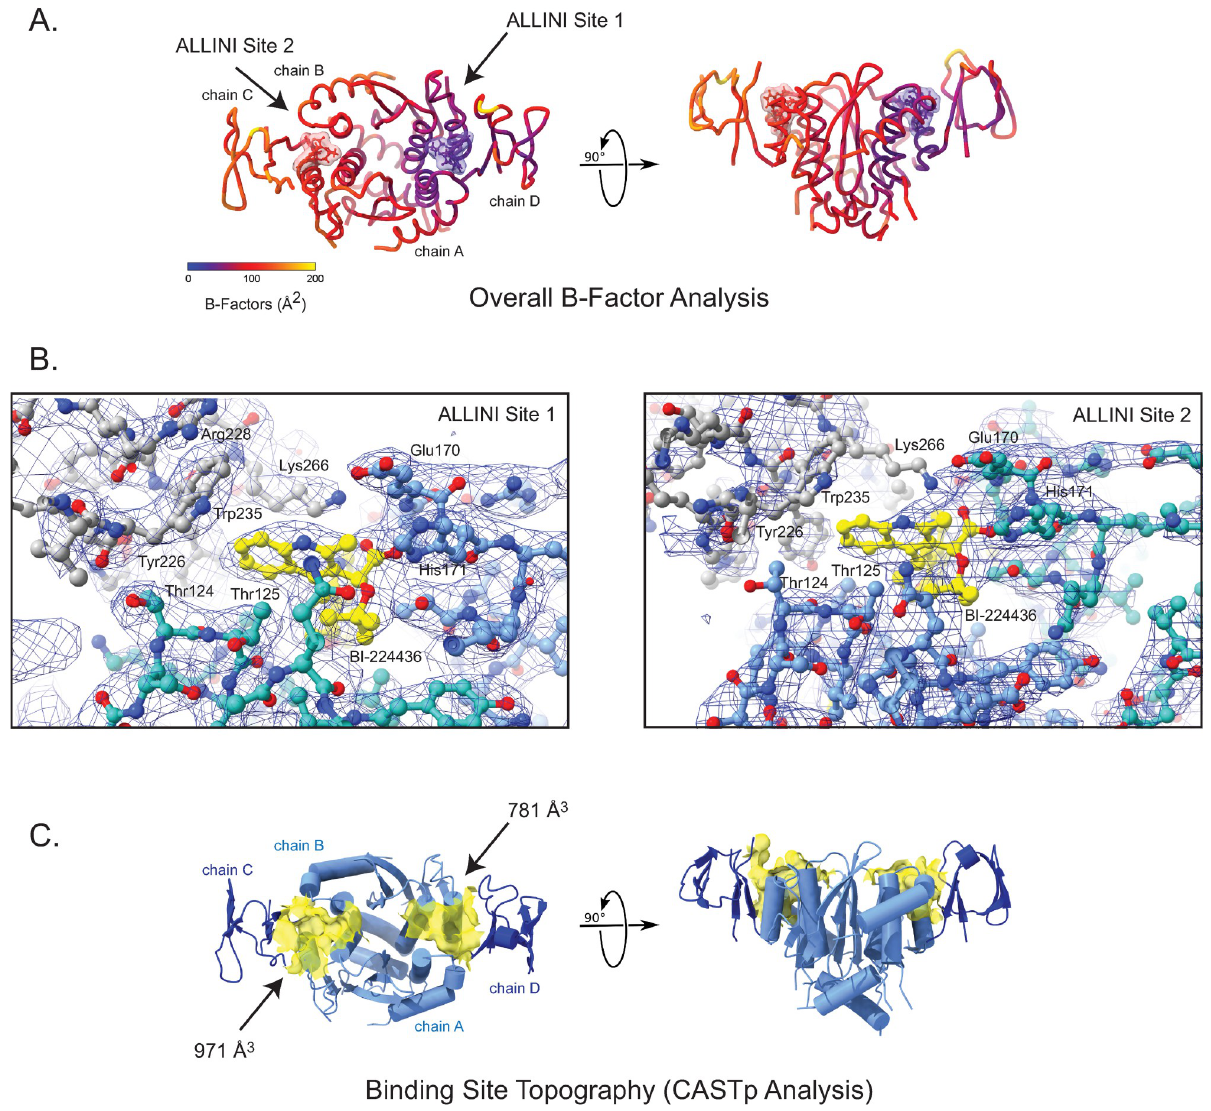
Fig 3. Evidence for asymmetry in the minimal ternary complex. A. B-factor analysis. A color key depicts the overall B-factor of the atomic structure. B. Representative sigma A-weighted 2F o -F c electron density, contoured at 1 σ at the first (left) and second (right) ALLINI binding sites. In the second site, side chain electron density is lost or diminished at key interfacial interactions including Lys-266, Arg-228, and Thr-124. C. Analysis of the surface of the ALLINI binding site using CASTp reveals at large binding pocket volume at ALLINI site 2 (971 A 3 ) when compared to ALLINI site 1 (781 A 3